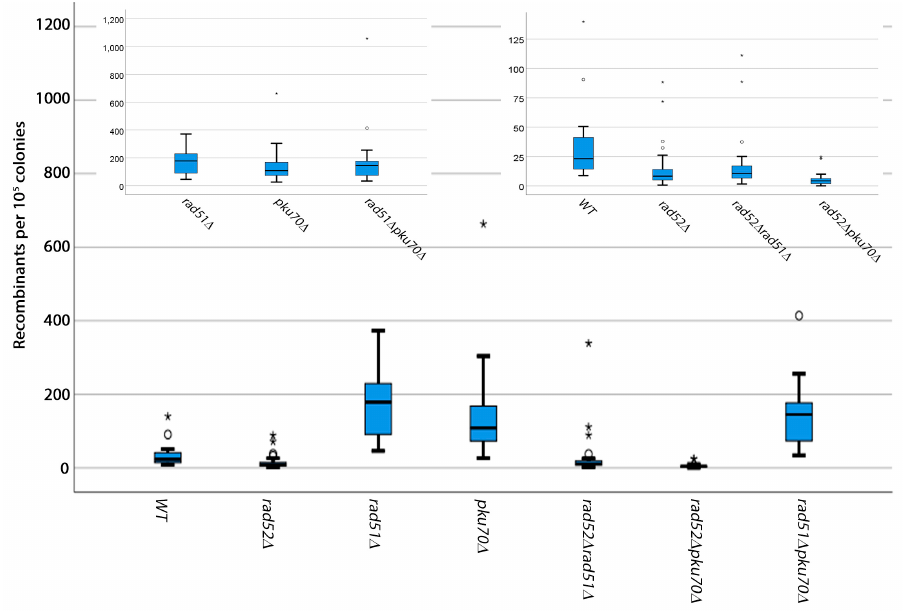
Figure 2. Genetic requirements for spontaneous breaks. Box plots showing the spontaneous recombination frequency per 10 5 colonies. Cells were grown on EMM-Uracil plates for 3–5 days at 32 ◦ C. For clarity, insets are shown for strains with similar recombination frequencies.